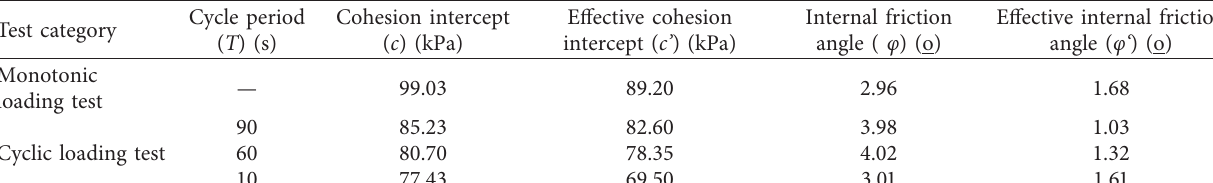
Figure 8: Shear strength ratio of sliding zone soil at different confining pressures ( N � 100). Table 3: Results of monotonic and multistage loading tests for 100